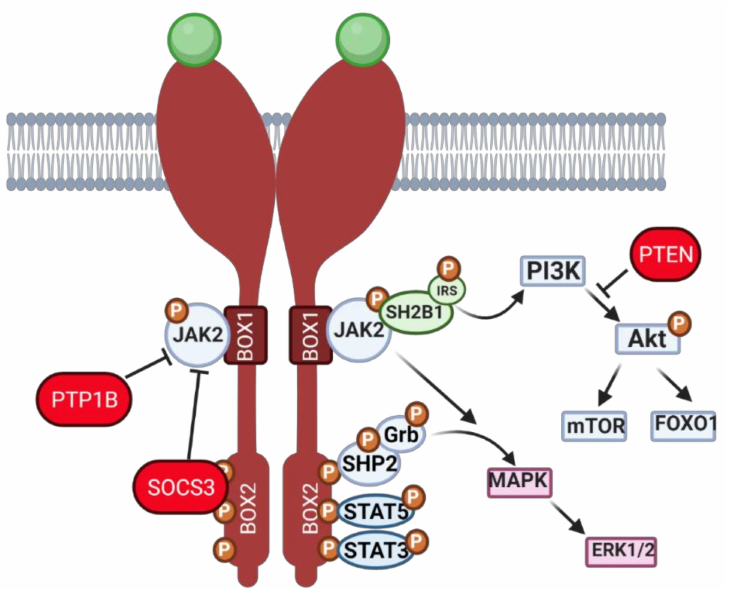
Figure 1. Schematic representation of leptin signaling pathway cascade. Leptin binds to its dimerized membrane receptor, and signal propagation starts. Janus kinase 2 (JAK2) phosphorylation causes transition of phosphate groups to three tyrosines within BOX2 of ObR and activation of (i) SH2- domain containing protein tyrosine phosphatase (SHP-2), which, in turns, binds its adapter molecule Grb-2 and activates downstream signaling, resulting in extracellular signal regulated kinase (ERK) 1/2 activation, (ii) signal transducer and activator of transcription (STAT) 5 activation and (iii) STAT3 activation. The phosphorylation of JAK2 also activates the MAPK signaling pathway and promotes SH2B adaptor protein 1 (SH2B1) and insulin receptor substrate (IRS) binding, which initiates the phosphatidylinositol 3 kinase (PI3K) pathway, which leads to phosphorylation of protein kinase B (Akt), mammalian target of rapamycin (mTOR) and forkhead box O1 (FOXO1) activation. During hyperactivation of the leptin signaling pathway, two main inhibitors can be transcribed—protein tyrosine phosphatase ( PTP ) 1B, which dephosphorylates JAK2 and suppressor of cytokine signaling (SOCS) 3, which blocks tyrosine and JAK2 phosphorylation. Created with BioRender.com,